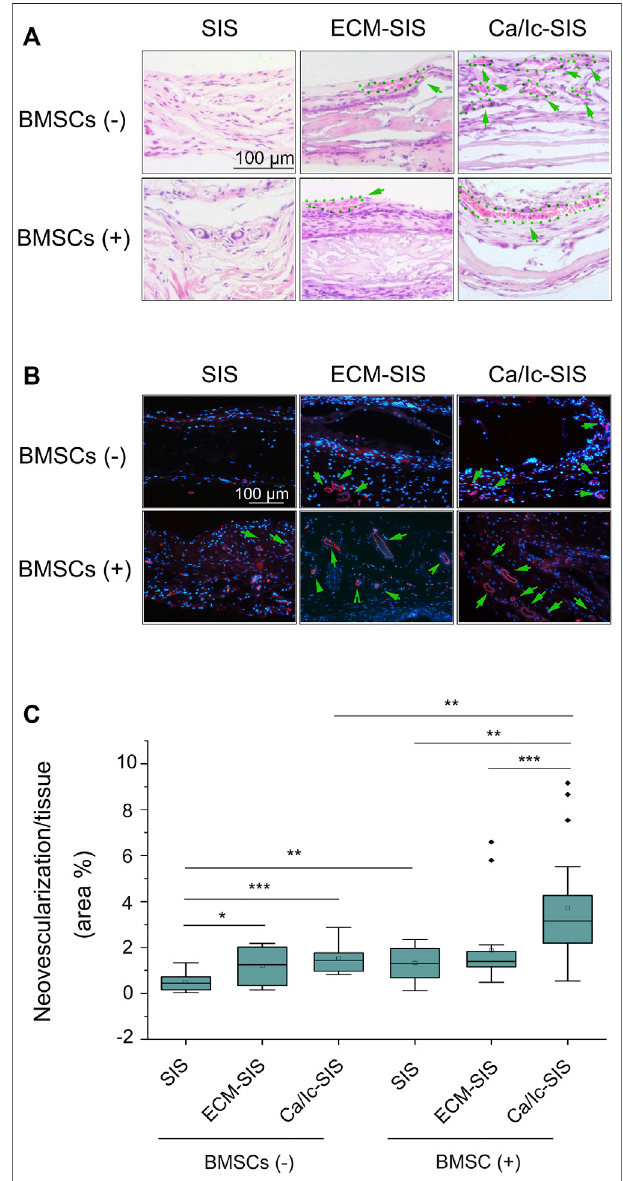
FIGURE 6 | (A) Histological images (H&E staining) of various vascular- like structuresin the groups. (B) Immuno fl uorescence stainingfor CD31 in the scaffolds8 weeksaftertheimplantation invivo .Newvesselswereidenti fi edby positive CD31 staining (red), and the nuclei were stained with DAPI (blue). (C) Box plots showing the area percentage of new vessel formation in the SIS, ECM-SIS, and Ca/Ic-SIS (with and without seeding BMSCs) scaffolds. The area of neovascularization and implanted tissue was quanti fi ed by ImageJ software. Five sections were measured for each mouse and four micewereanalyzedforeachgroup.*, p < 0.05,**, p < 0.01,and***, p < 0.001. Scale bar: 100 μ m. Green arrows directed blood vessels and the corresponding regions were circled by green dotted